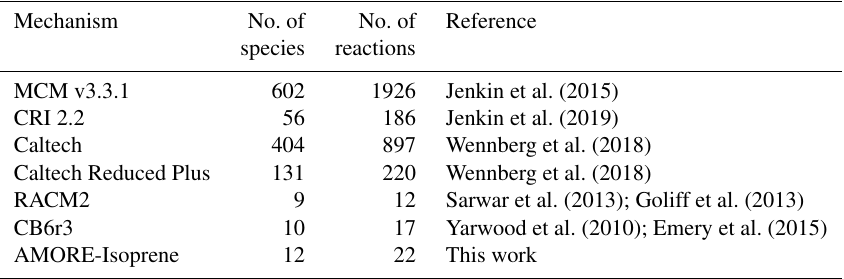
Table 1. Sizes of select isoprene mechanisms, including the mechanism in this work. Larger mechanism sizes are self-reported. For smaller mechanisms, species and reactions were recounted for this work using the following criteria: (i) only species unique to isoprene chemistry are included, which excludes species that do not contain the isoprene carbon backbone; (ii) all reactions involving species unique to isoprene are counted; and (iii) heterogeneous reactions involving isoprene species are not